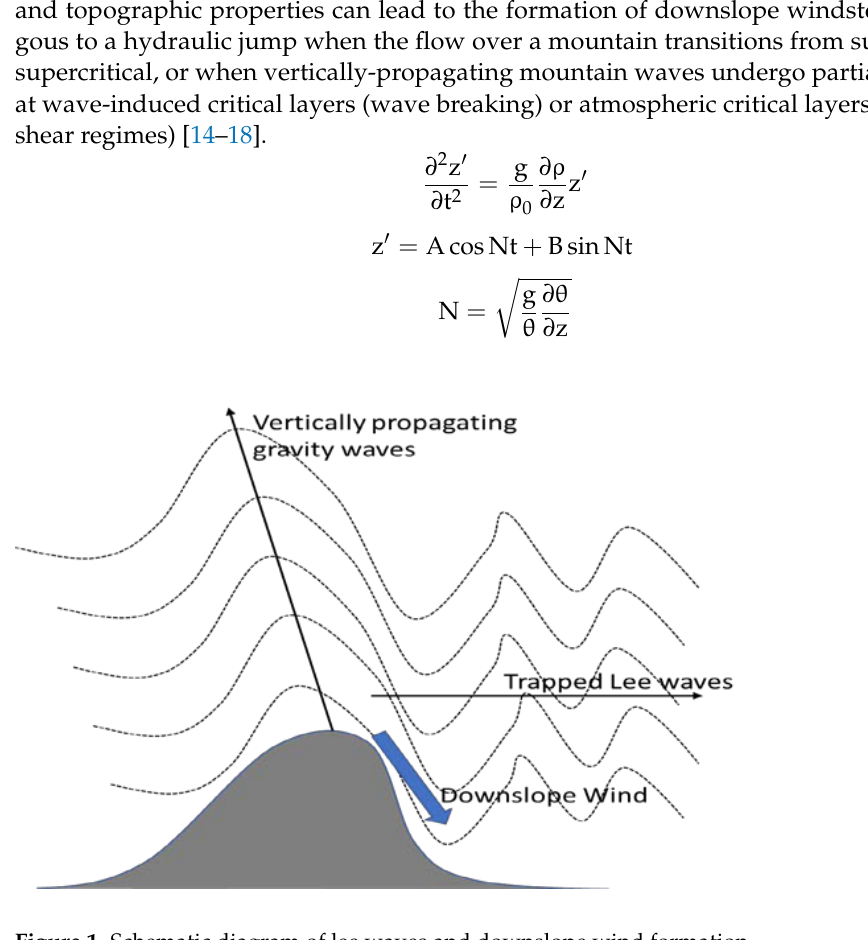
Figure 1. Schematic diagram of lee waves and downslope wind formation.